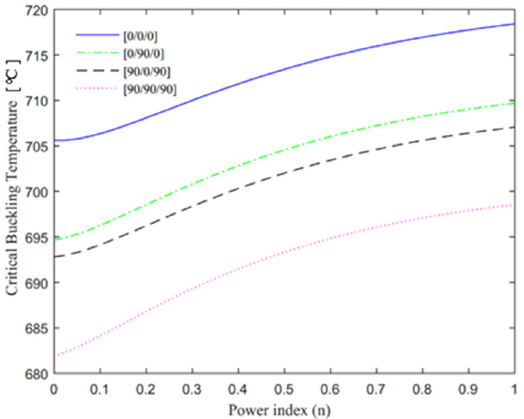
Figure 5. E ff ect of stacking sequence on the nonlinear fundamental frequency. Figure 5. Effect of stacking sequence on the nonlinear fundamental frequency.